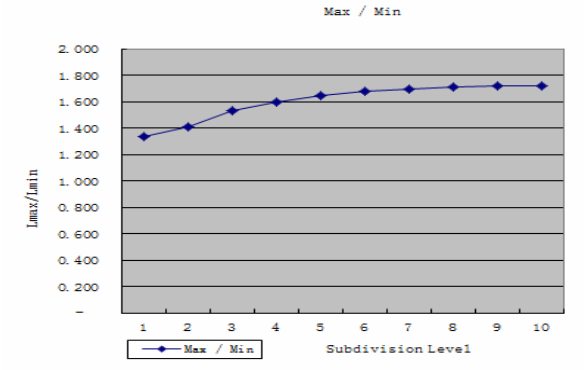
Figure 9 The ratio of max and mix edge